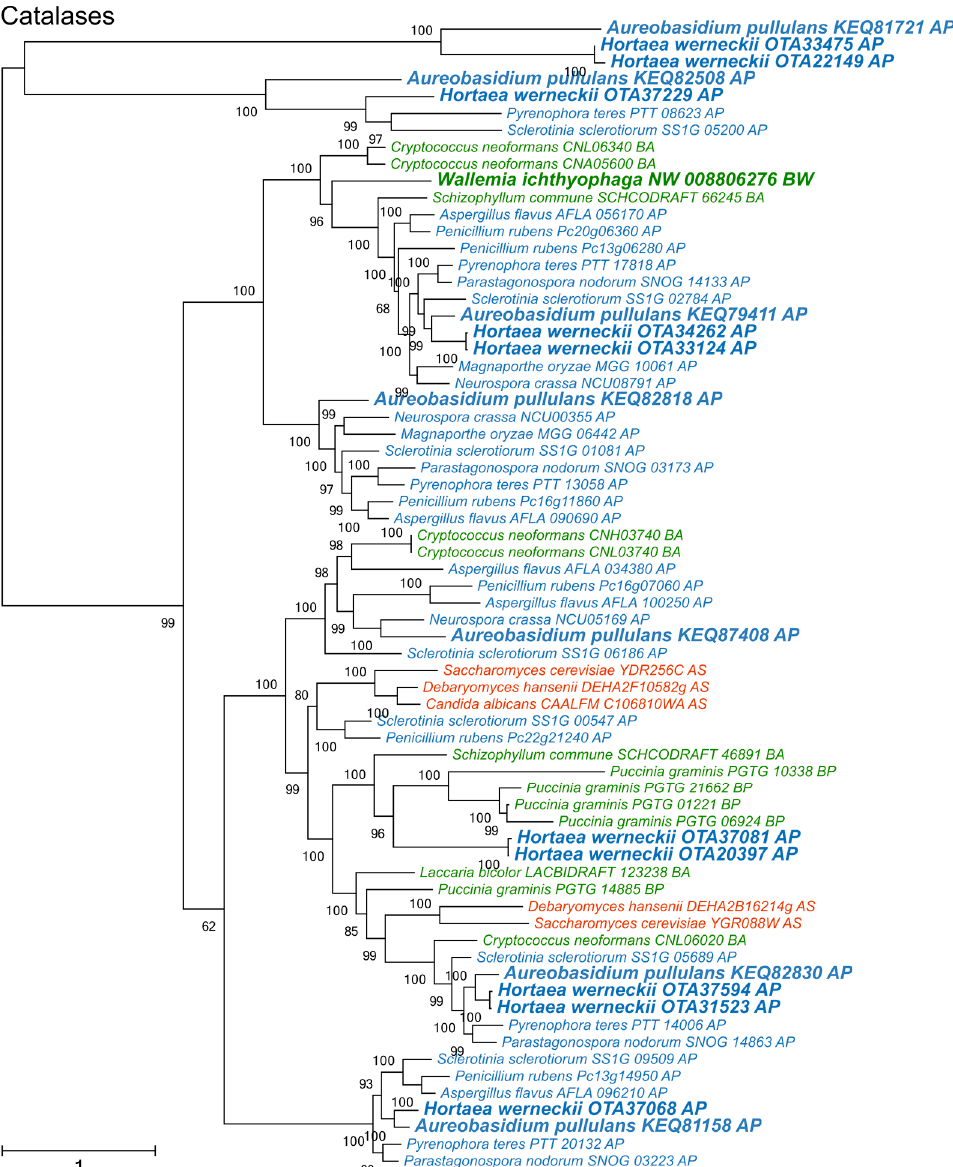
Figure 3. Maximum likelihood phylogeny of genes encoding catalases. The phylogeny was estimated by PhyML software with aLRT implementation for the calculation of branch supports as Chi-squared based support. Species name is followed by protein accession number and by a two letter